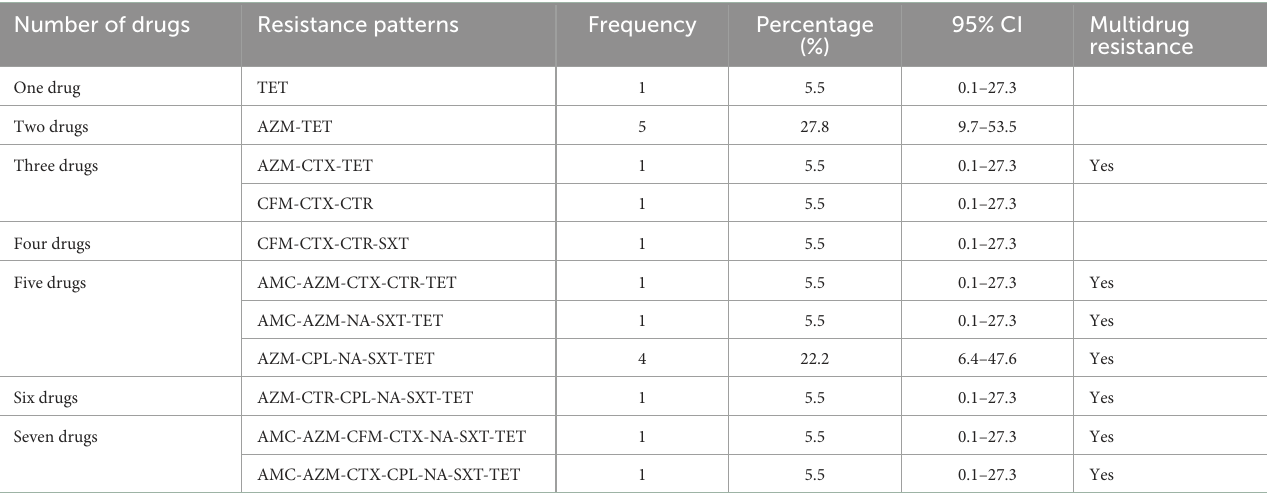
TABLE 4 Multidrug resistance patterns of Salmonella